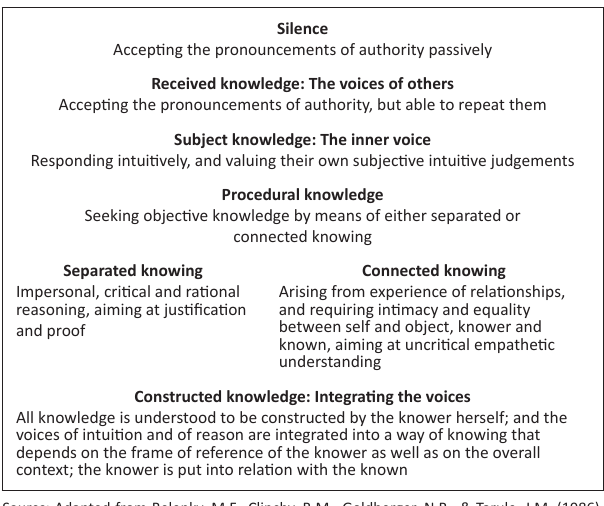
FIGURE 1: Model of epistemological